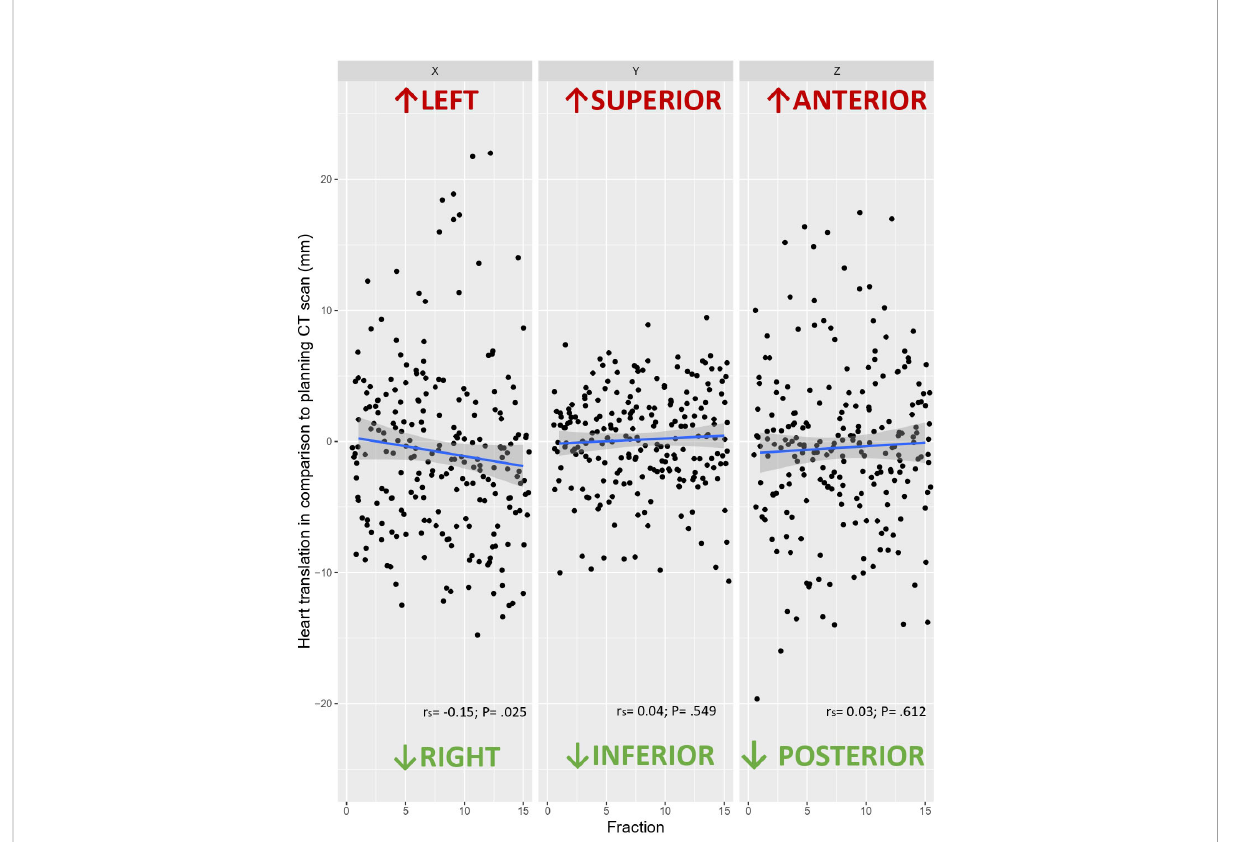
FIGURE 1 Heart translation in each axis (X, Y, Z) in comparison to the planning CT scan according to the 225 CBCTs, with the linear correlation (blue line) and its 95% con fi dence interval (gray